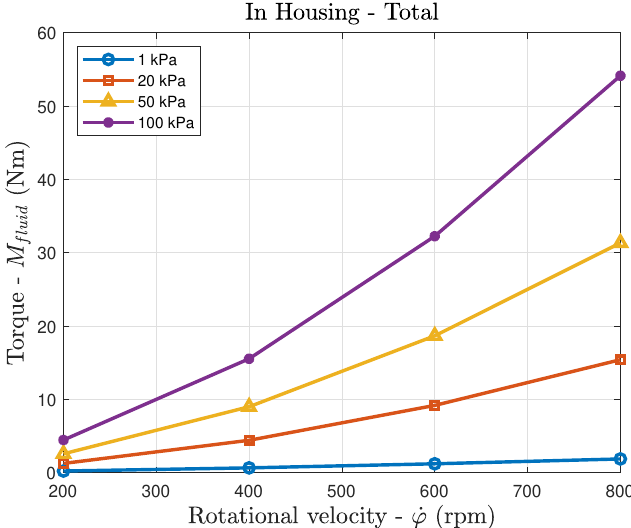
Figure 6. Total fluid friction torque as a function of the rotational velocity at different pressure